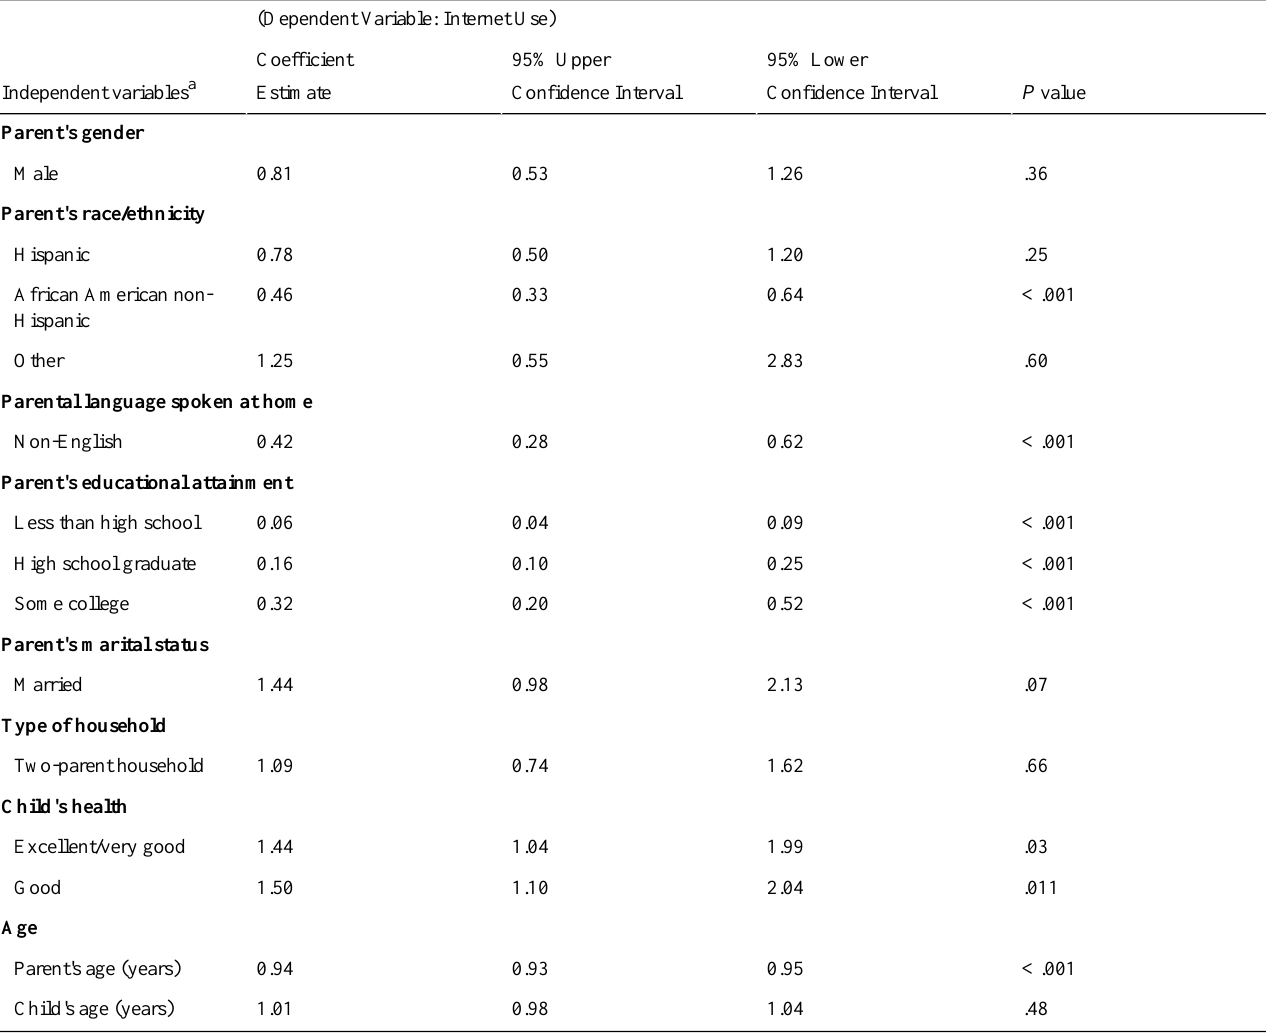
Table 3. Multivariate logistic regression (Dependent Variable: Internet